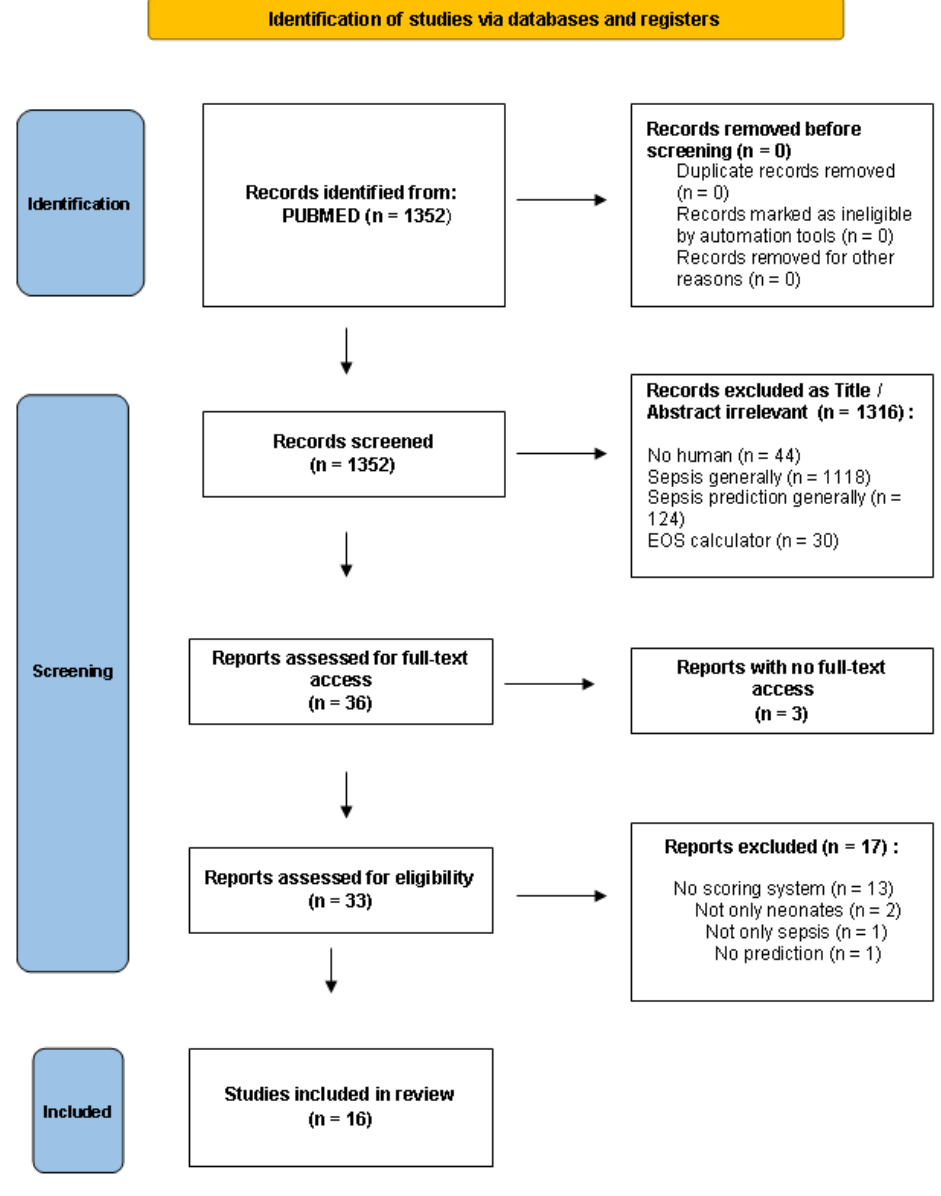
Figure 1. Preferred Reporting Items for Systematic Reviews and Meta-Analyses (PRISMA) 2020 diagram of the studies included at each stage of the screening process.